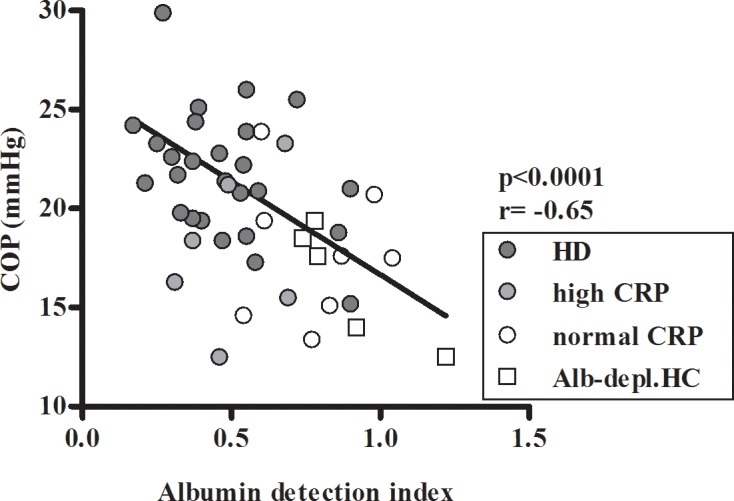
The association of COP with albumin detection index in sera.The association of COP (measured in serum) with albumin detection index was analyzed using selected subject's sera with albumin levels within a narrow range of 1.9–2.9 g/dl. HC sera with albumin levels within this range were obtained by partial albumin depletion (Alb-depl.HC).